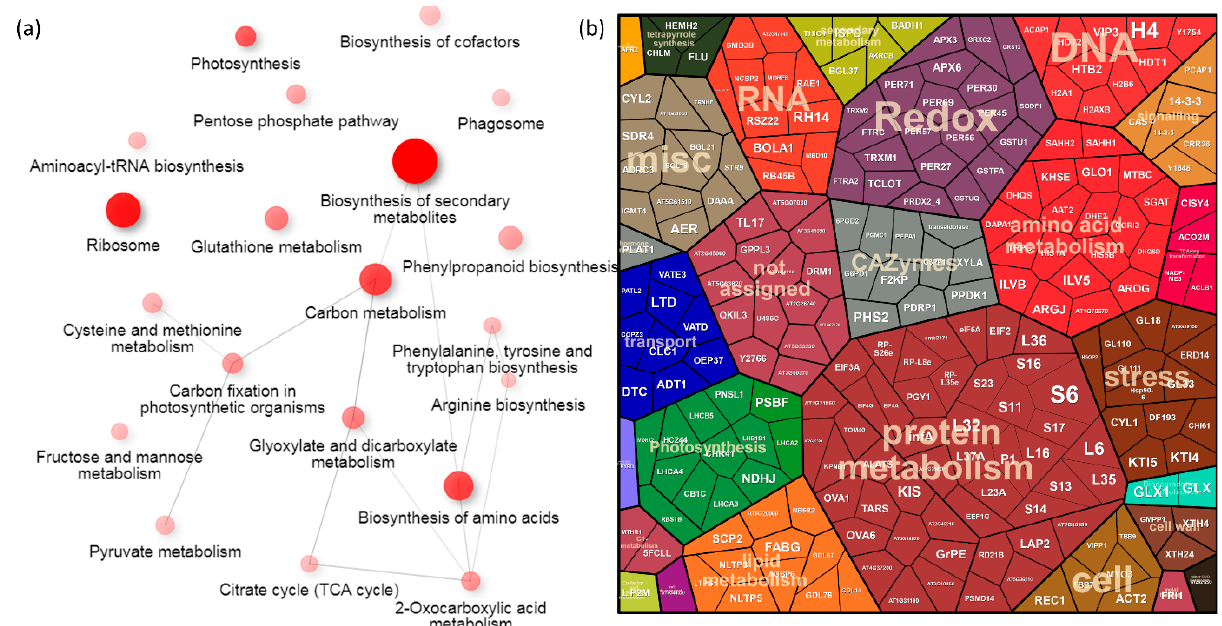
Figure 5. Diurnal variation in phyB mutant. ( a ) The most significant metabolic pathways found in diurnally regulated proteins and ( b ) visualization of all differentially abundant proteins ( p < 0.05, at least a 1.5-fold change) in the ProteoMap. For details, see Supplementary Table S1.